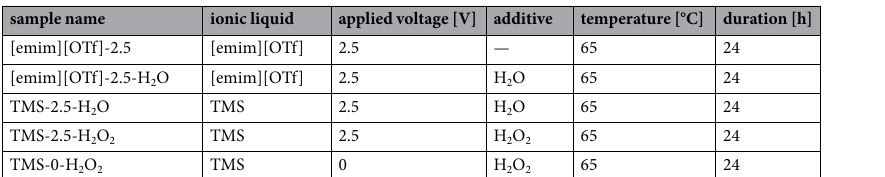
Table 1. Sample names and experimental